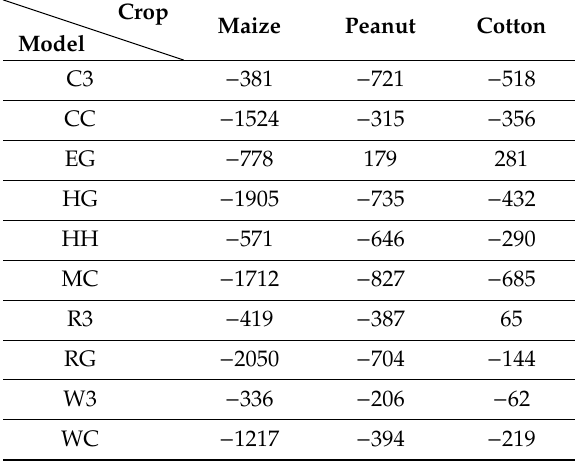
Table 4. Ten simulated NARCCAP regional-model-driven crop dry matter yield di ff erences between future (2041–2070) and current (1971–2000) runs under rainfed conditions. Unit is of kg ha − 1